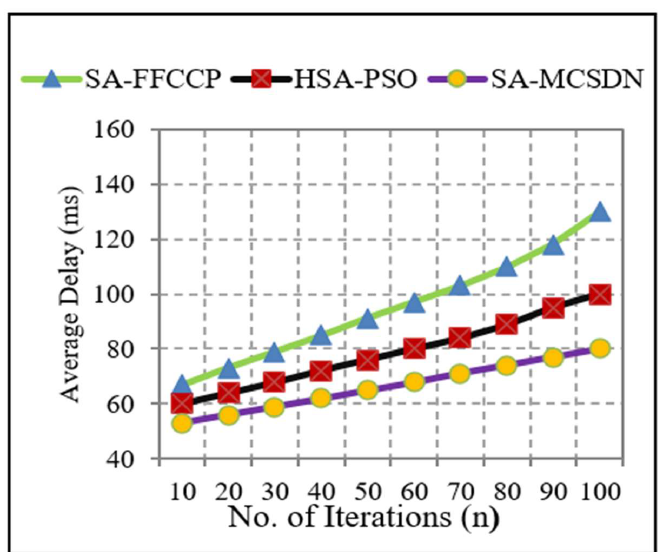
Figure 9. Comparison of average delay.